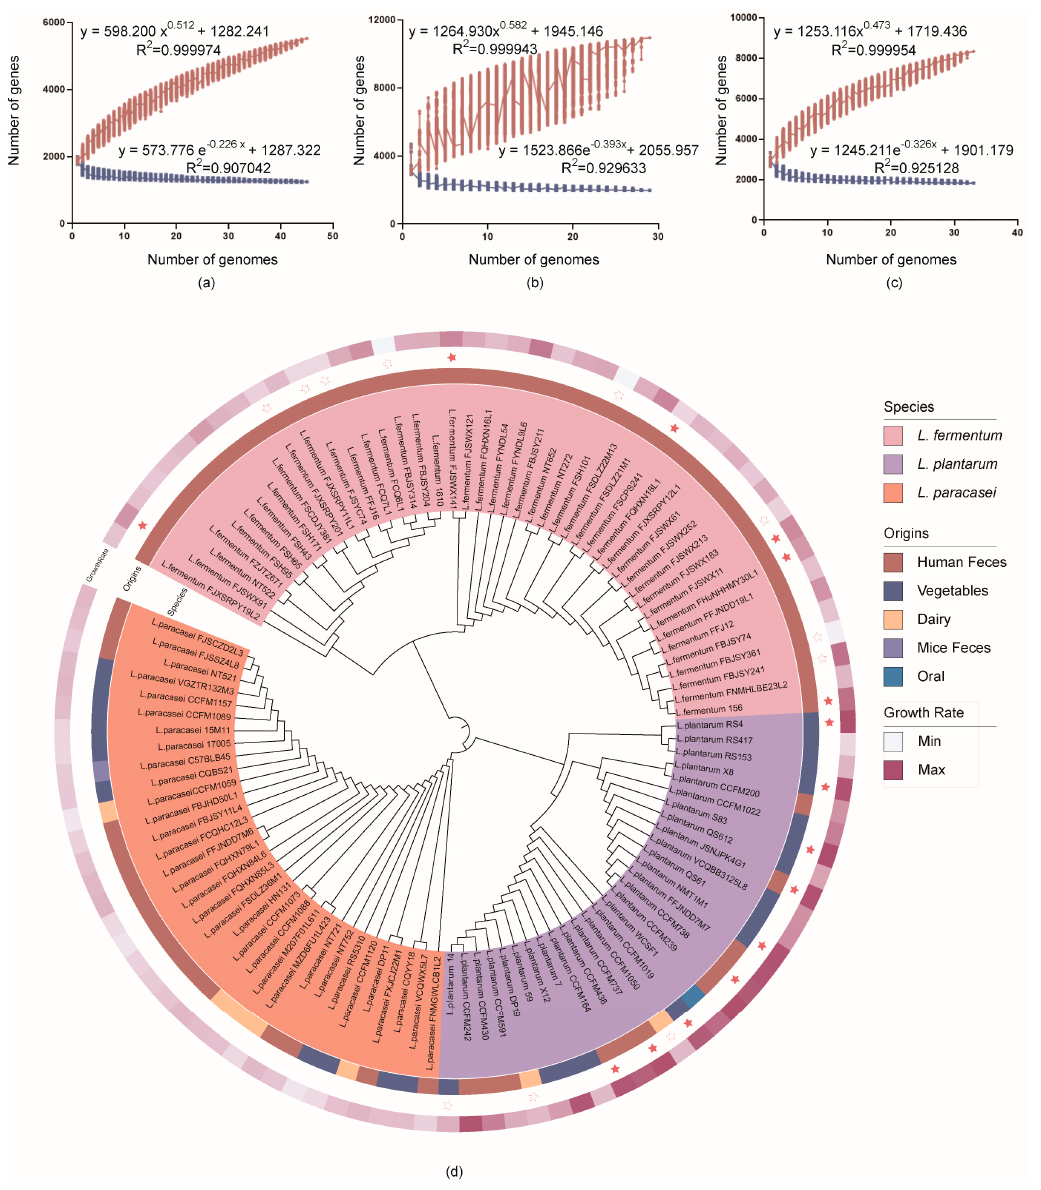
Figure 3. The pan-genome (in brown) and core-genome (in dark blue) estimates expressed as the accumulated number of genes in relation to the number of strains. ( a ) L. fermentum . ( b ) L. plantarum . ( c ) L. paracasei . ( d ) Phylogenetic tree of 107 Lactobacillus strains. Solid stars represent tolerant strains and hollow stars represent sensitive strains selected for comparative